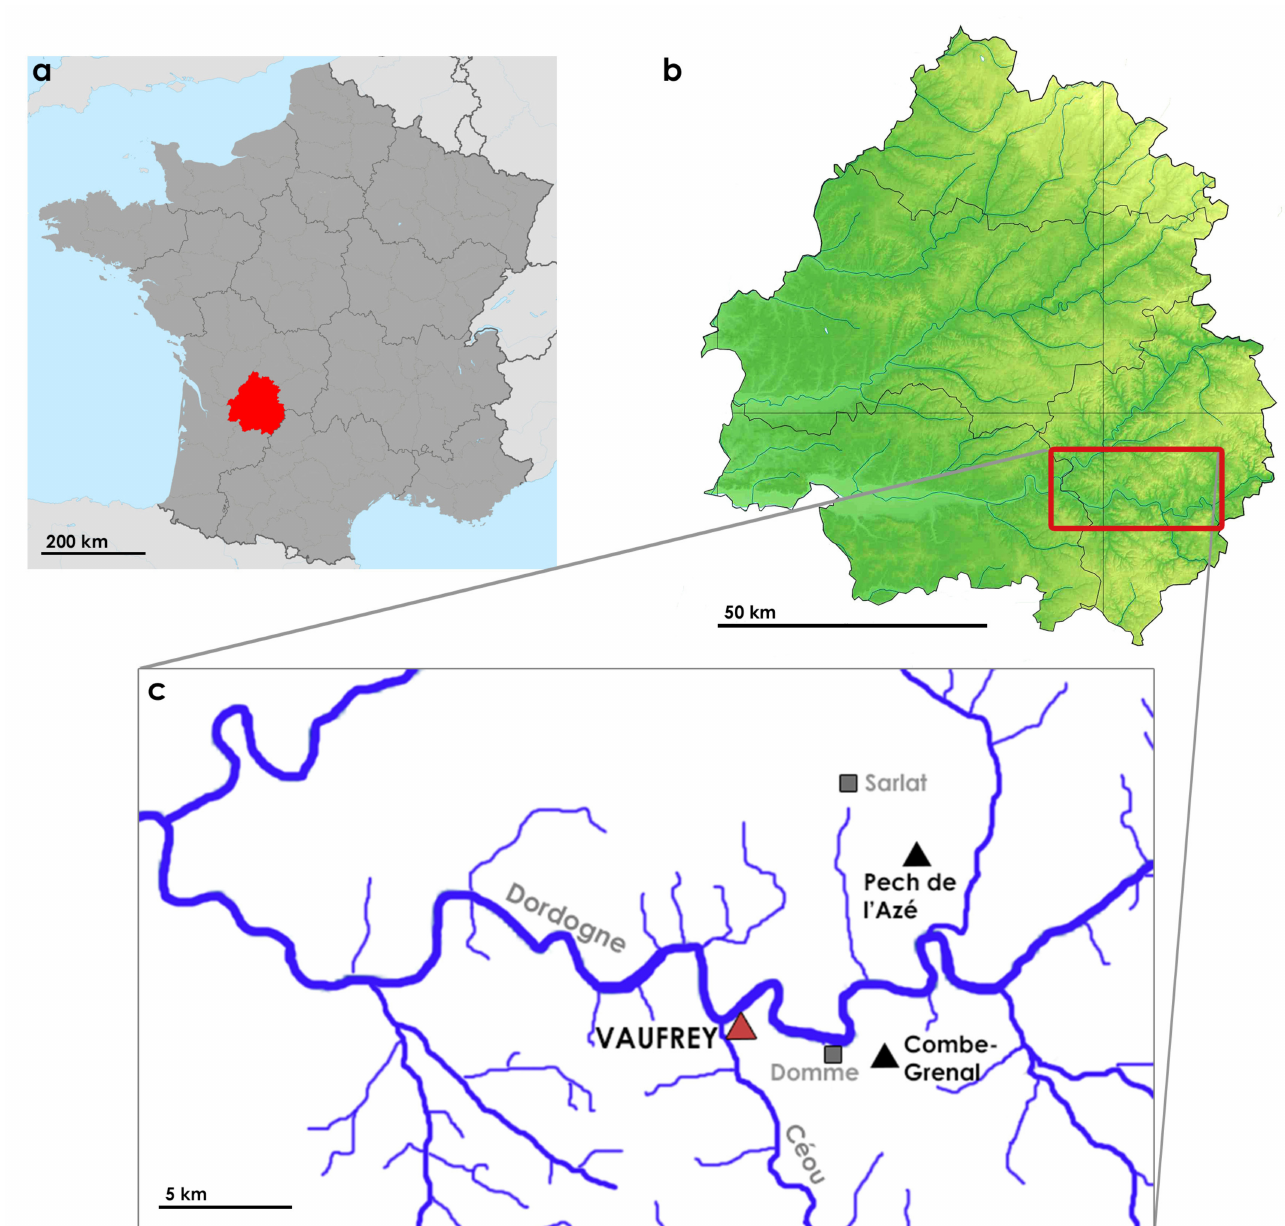
Figure 1. Location of Grotte Vaufrey (or Grotte XV) within Dordogne area. ( a ) Map of France with the location of the Dordogne region marked in red; ( b ) Dordogne region with the specific area of interest along the Dordogne river; ( c ) location of Grotte Vaufrey, at C é ou and Dordogne